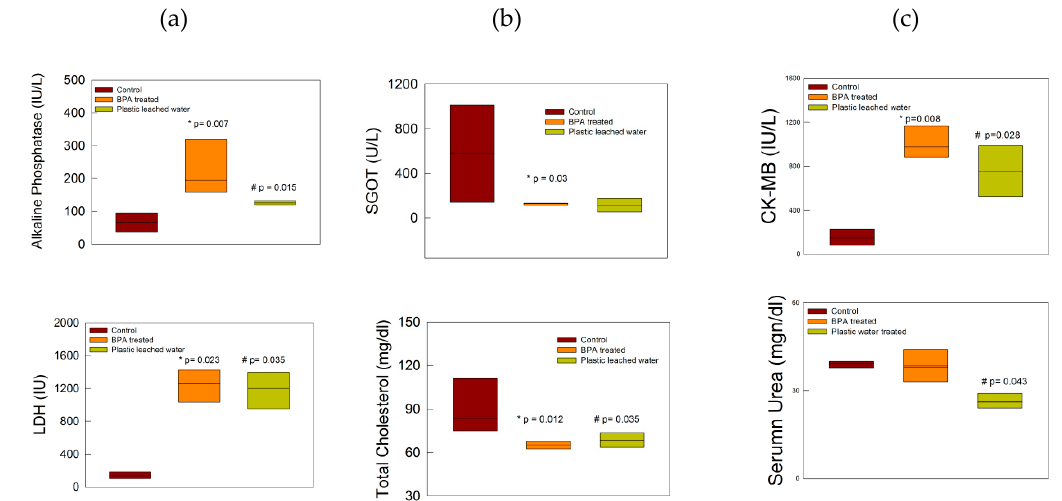
Figure 1. ( a ) Alkaline phosphatase (ALP) and lactate dehydrogenase (LDH) levels increased in the treated groups as compared to control group, ( b ) serum glutamic oxaloacetic transaminase (SGOT) and total cholesterol decreased in treated groups as compared to control group, ( c ) creatine kinase-muscle / brain (CK-MB) markedly increased in both treated groups as compared to control group whereas urea decreased in the plastic leached water-treated group. * and # indicate p < 0.05 Mann–Whitney U test.